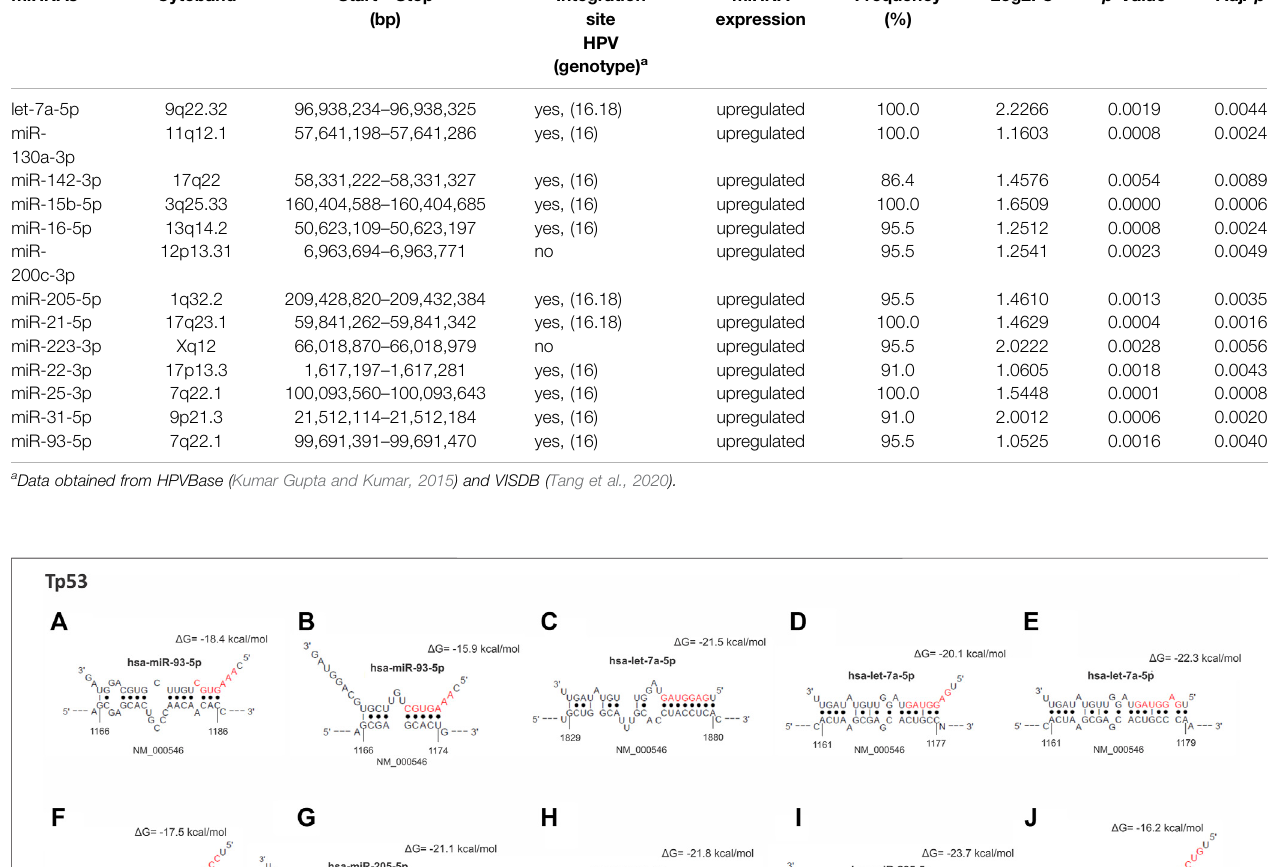
TABLE 2 | Thirteen differentially expressed miRNAs observed upregulated in the PeCa patients, and their respective chromosomal location and HPV integration sites (presented by miRNA number). miRNAs Cytoband Start — Stop